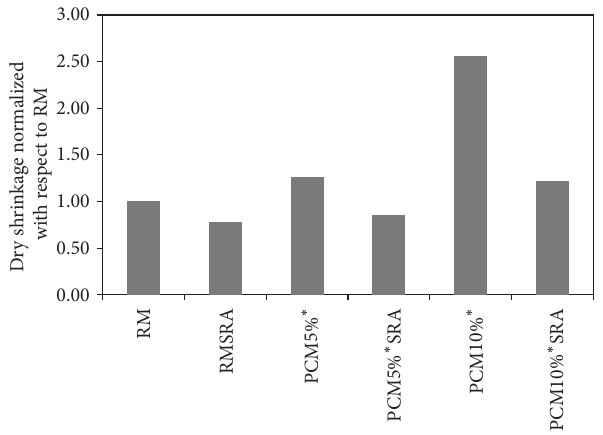
Figure 3: Dry shrinkage of mortars normalized with respect to reference mortar